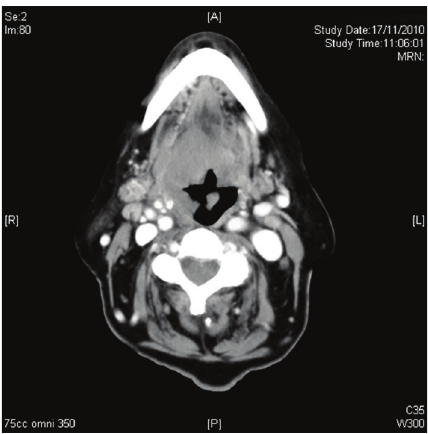
Figure 1: Computed tomography at presentation.